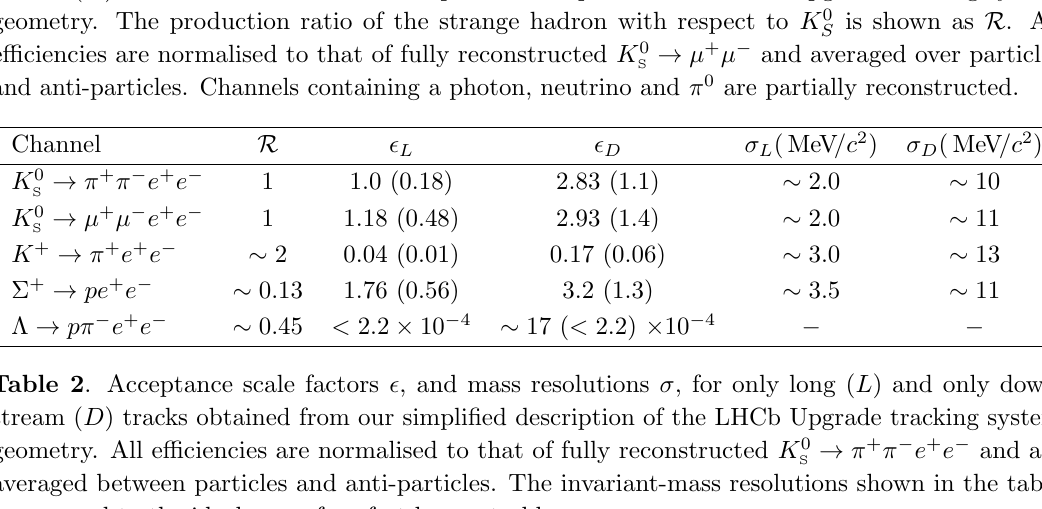
(cid:25) + (cid:25) (cid:0) e + e (cid:0) and are S !